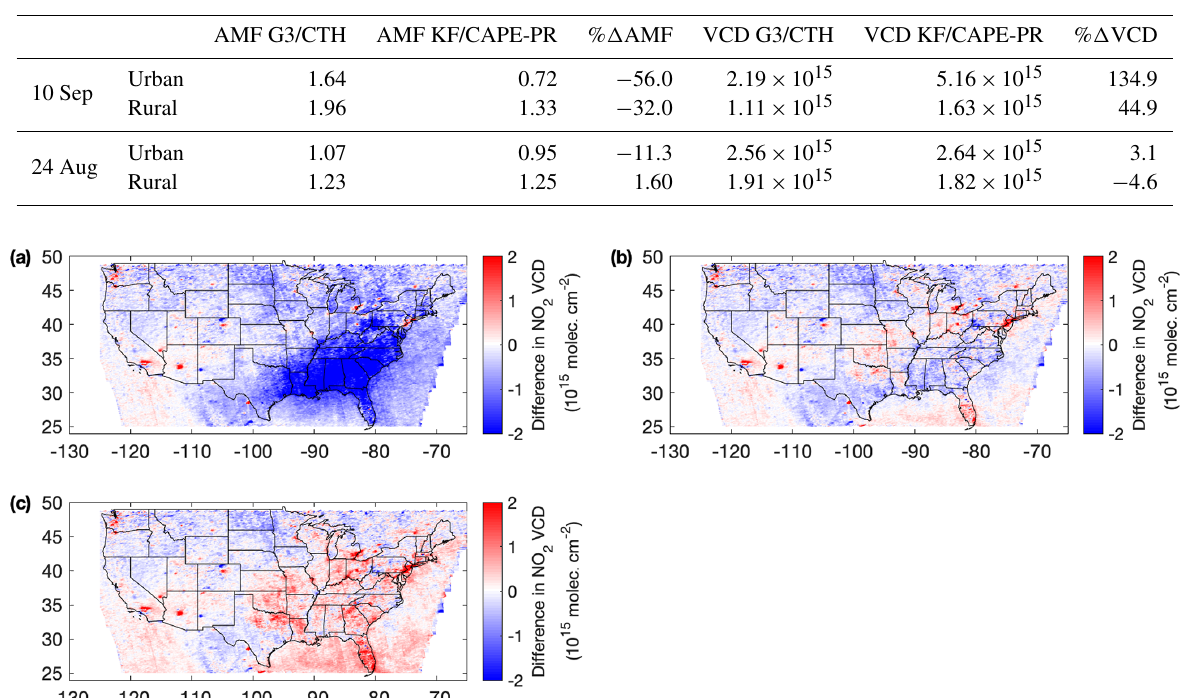
Figure 4. Difference in NO 2 VCD between BEHR retrievals and WRF-Chem (WRF-Chem − BEHR). Panel (a) excludes LNO x in model simulation, and panel (b) adds LNO x emissions with a production rate of 500molNO flash − 1 . Panel (c) includes the same LNO x emissions as panel (b) but uses NO 2 profiles scaled upward by 60% at pressure lower than 400hPa. The average time covers 13 May to 23 June 2012. Pixels with a cloud fraction larger than 0.2 are filtered out in the